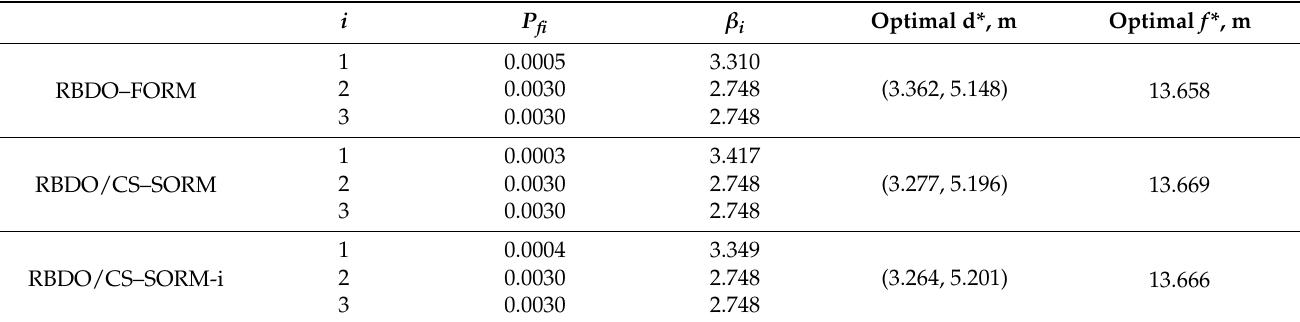
Table 12. Results of the RBDO/CS–SORM/SORM-i and RBDO–FORM for the ductile frame structure.